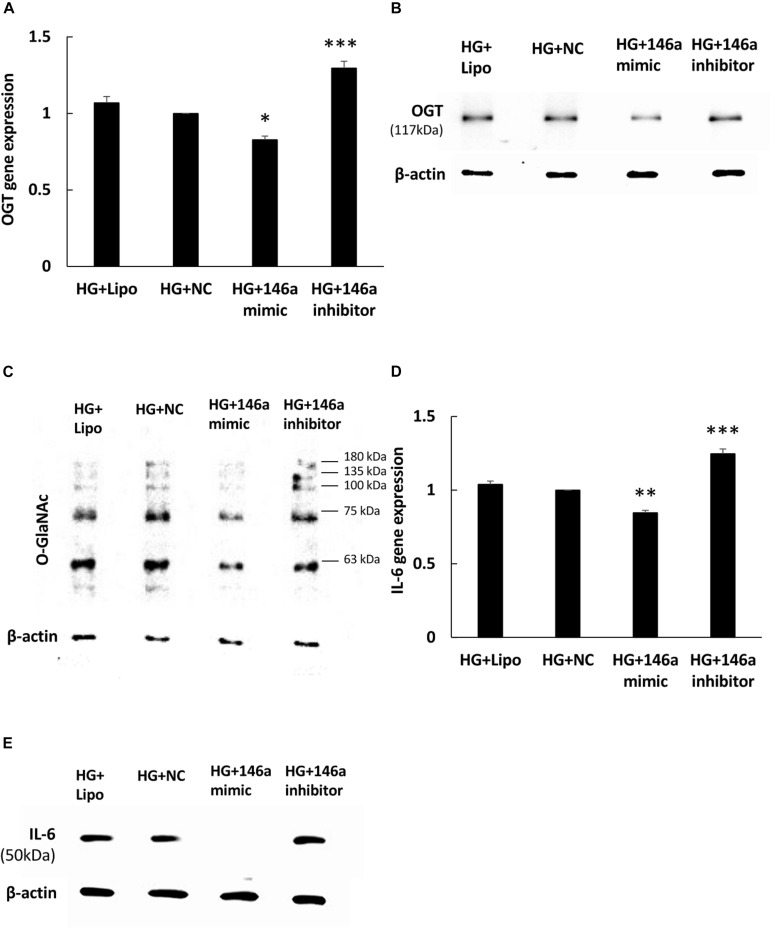
(A–E) miR-146a-5p mimic and inhibitor regulated HG-induced OGT mRNA and protein expression, protein O-GlcNAcylation, and IL-6 mRNA and protein expression. (A) Transfection of miR-146a-5p mimic inhibited HG-induced OGT mRNA expression to 83% of the control level. N = 4. ∗p < 0.05 compared with the HG-treated HAECs transfected with a negative control (HG + NC). Conversely, transfection of miR-146a-5p inhibitor enhanced HG-induced OGT mRNA expression by 1.30-fold. N = 4. ∗∗∗p < 0.001 compared with HG + NC. (B,C) The stimulatory effect of HG on OGT protein and protein O-GlcNAcylation expression levels were significantly inhibited in the miR-146a-5p mimic-transfected HAECs compared to the HAECs transfected with negative control. Conversely, transfection of miR-146a-5p inhibitor increased HG-induced OGT protein and protein O-GlcNAcylation expression levels. The blot is representative of three independent experiments. (D) Transfection of miR-146a-5p mimics inhibited HG-induced IL-6 mRNA expression to 85% of the control level, respectively. N = 4. ∗∗p < 0.01 compared with HG + NC. Conversely, transfection of miR-146a-5p inhibitor increased HG-induced OGT mRNA expression by 1.25-fold. N = 4. ∗∗∗p < 0.001 compared with HG + NC. (E) The stimulatory effect of HG on IL-6 protein expression levels were significantly inhibited in the miR-146a-5p mimic-transfected HAECs than in the HAECs transfected with negative control. Conversely, transfection of miR-146a-5p inhibitor enhanced HG-induced IL-6 protein expression levels. The blot is representative of three independent experiments.